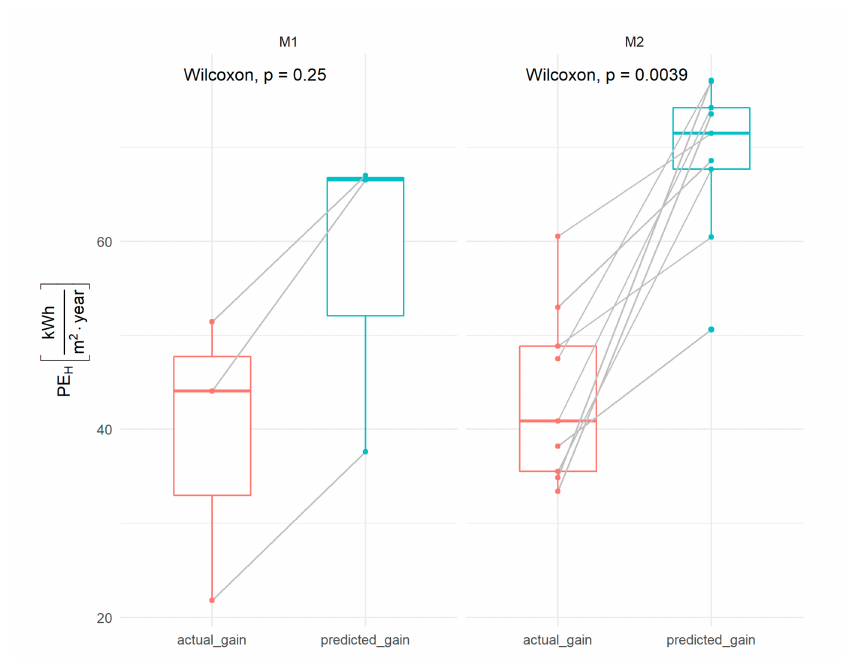
Figure 3. Decrease in the value of the PE H index calculated on the basis of measurements from the operation of buildings and indexes calculated on the basis of